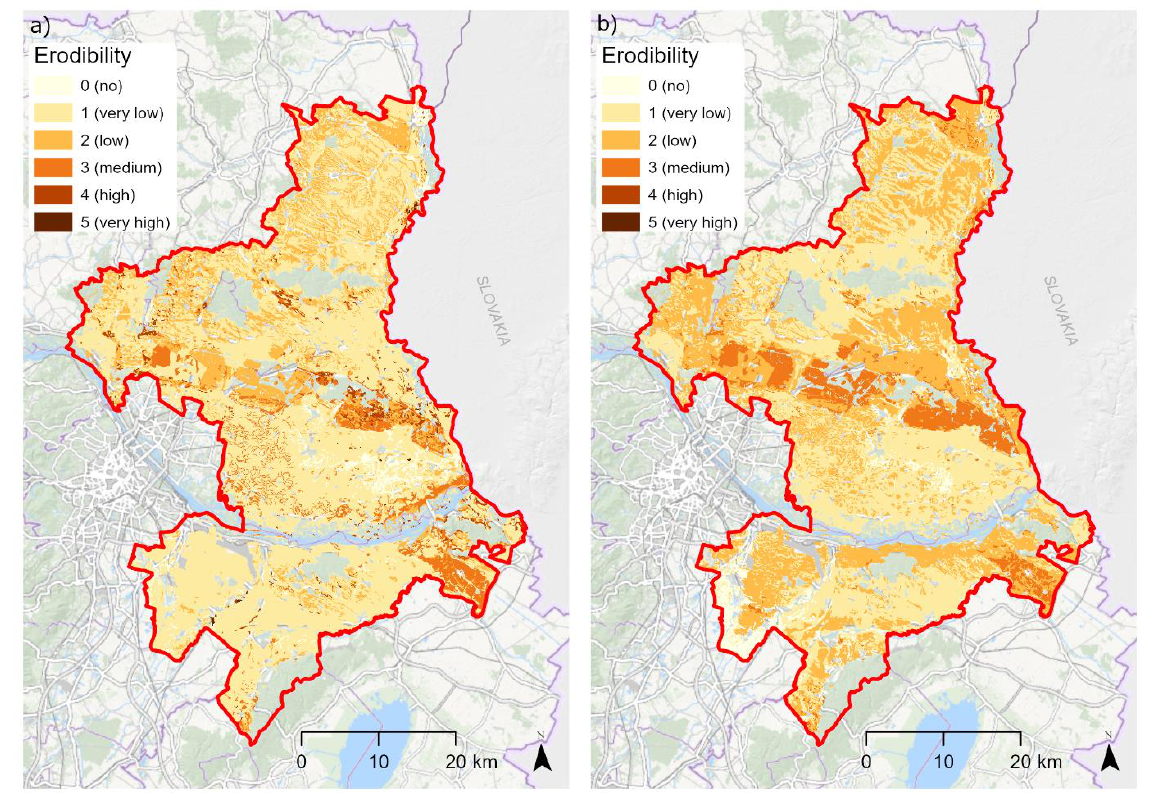
Figure 3. Erodibility maps of DIN 19706 ( a ) and revised wind erosion equation (RWEQ) ( b ) based on qualitative classes. Erodibility of RWEQ was classified according to six equal classes (range of 0.16).